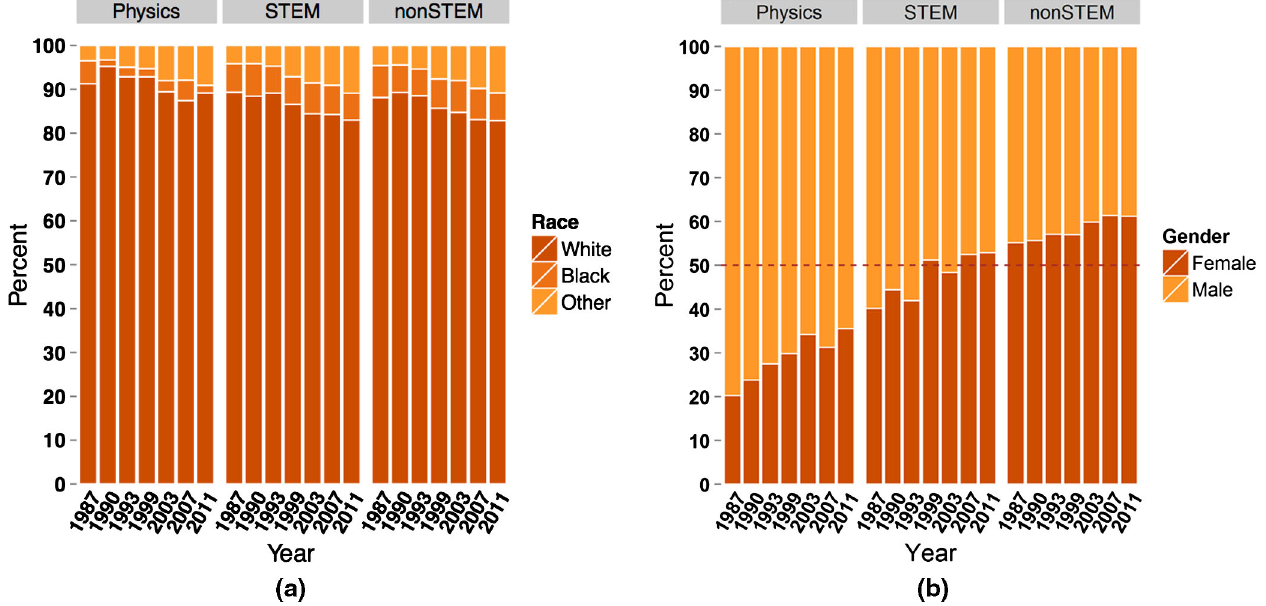
FIG. 6. (a) Racial distribution of physics, STEM, and non-STEM teachers calculated for each survey year (standard error ≤ 4 . 3 %). (b) Gender distribution of physics, STEM, and non-STEM teachers calculated for each survey year (standard error ≤ 2 . 99